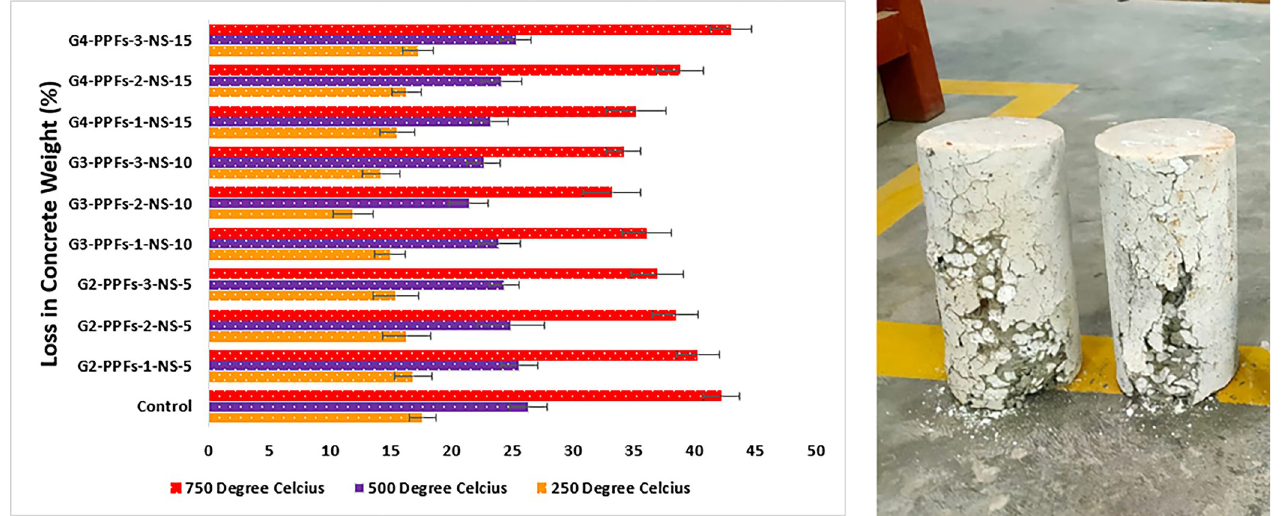
Fig 19. (a) Loss in UHS-GPC weight due to elevated temperature, (b) Concrete sample after exposure to elevated temperature.